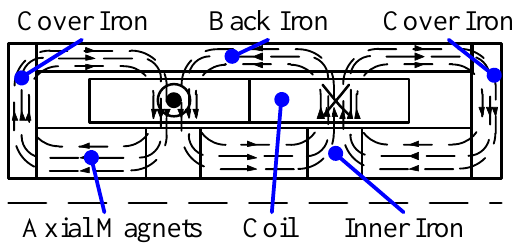
Figure 3. Open-circuit flux lines of the VCM.